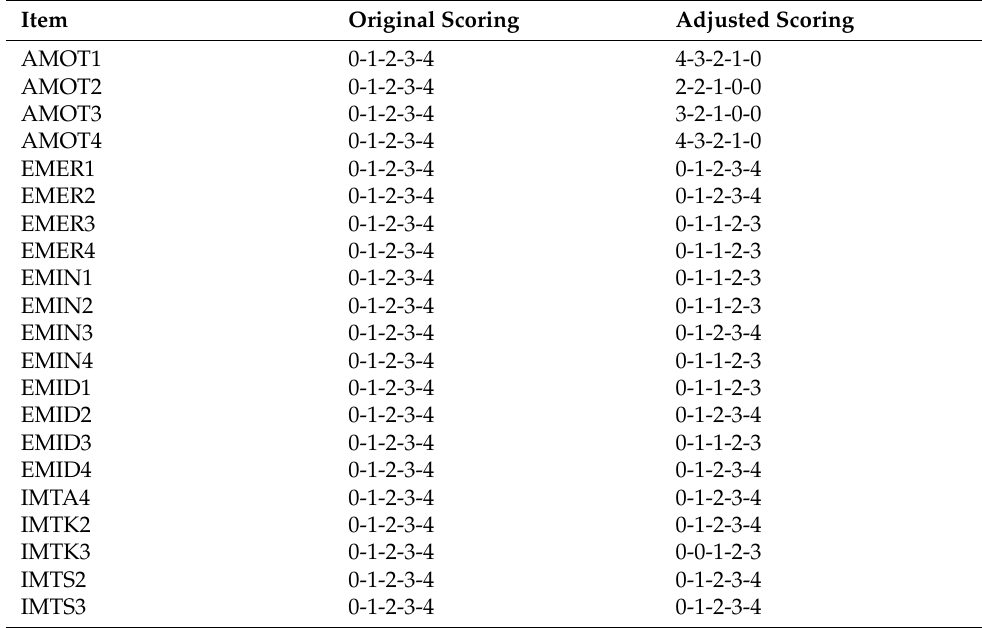
Table 4. Adjusted scoring